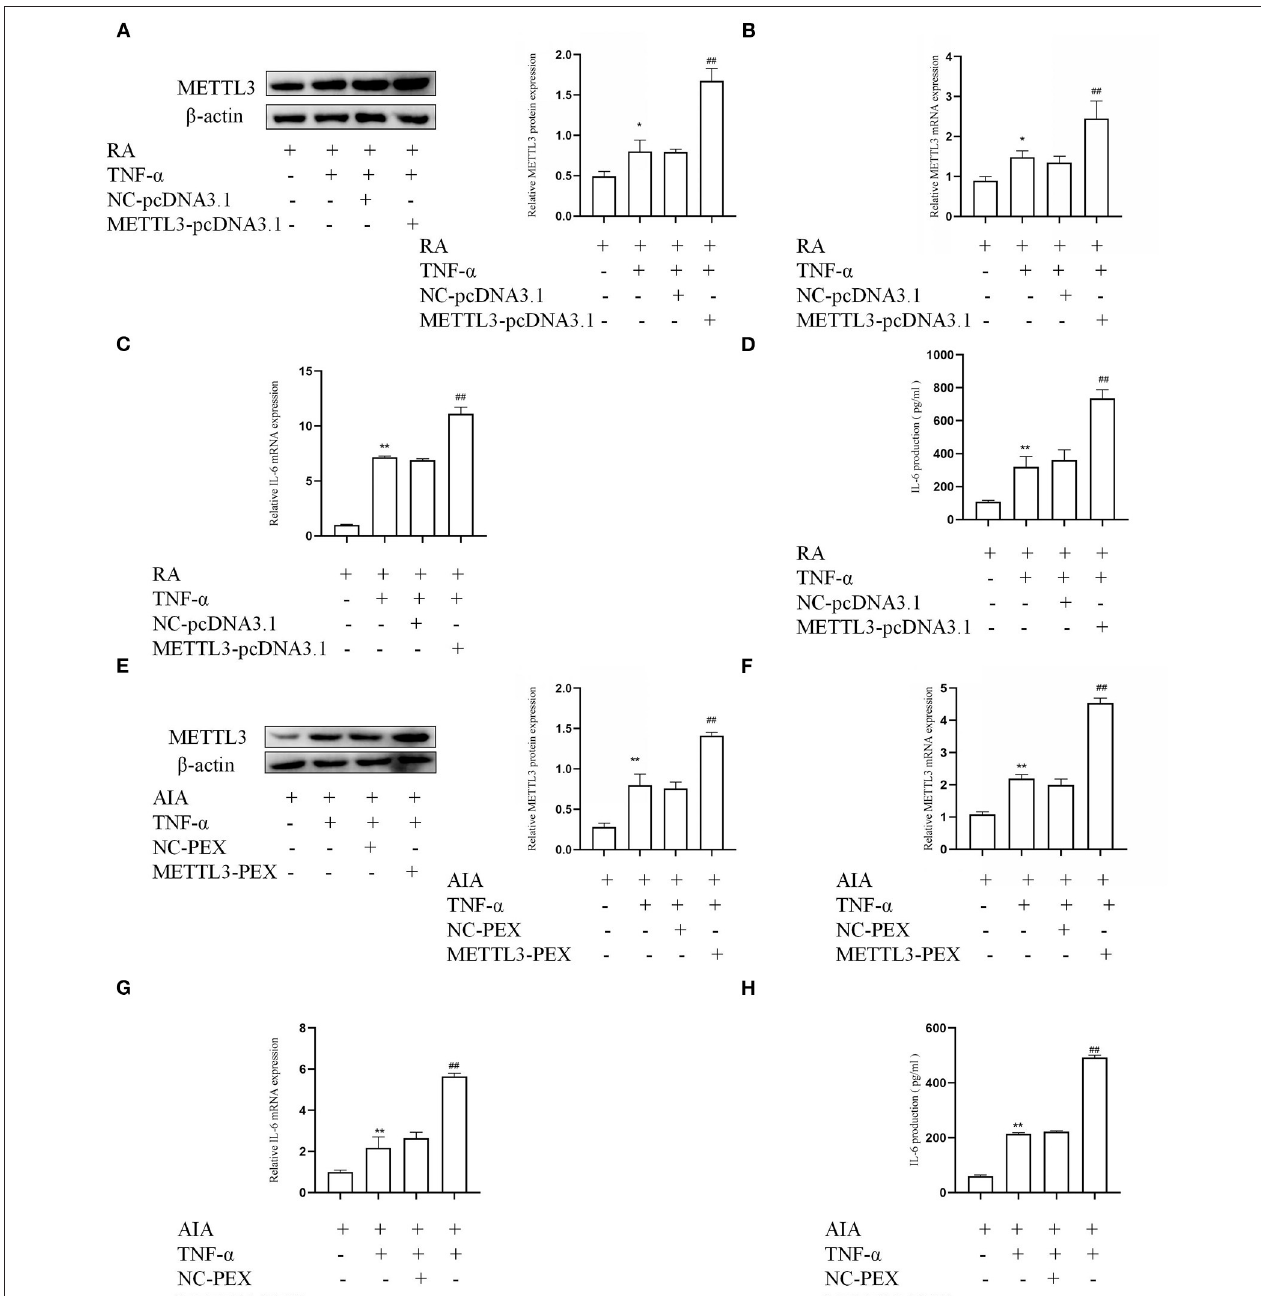
FIGURE 4 | Methyltransferase-like 3 (METTL3) overexpression along with high expression of inflammatory cytokines. (A) METTL3 protein levels in TNF- α -incubated rheumatoid arthritis fibroblast-like synoviocytes (RA-FLSs) with METTL3 overexpression, as detected by Western blotting. (B) METTL3 mRNA levels in TNF- α -incubated RA-FLSs after overexpressing METTL3, as detected by real-time quantitative PCR (qPCR). (C) IL-6 mRNA levels in TNF- α -incubated RA-FLSs after overexpressing METTL3, as detected by qPCR. (D) The number of IL-6 in TNF- α -incubated RA-FLS supernatants were analyzed by ELISA. (E) METTL3 protein level was measured by Western blotting in TNF- α -incubated AIA-FLSs after METTL3 overexpression. (F) METTL3 mRNA level was detected by qPCR in TNF- α -incubated AIA-FLSs after using METTL3-PEX. (G) IL-6 mRNA levels were detected by qPCR in TNF- α -incubated AIA-FLSs with overexpressed METTL3. (H) The number of IL-6 in TNF- α -incubated AIA-FLS supernatants were measured by ELISA after transfection. All of these values are presented as the mean ± SD. NC , negative control. * P < 0.05, ** P < 0.01 vs. the control group. ## P < 0.01 vs. the NC group.